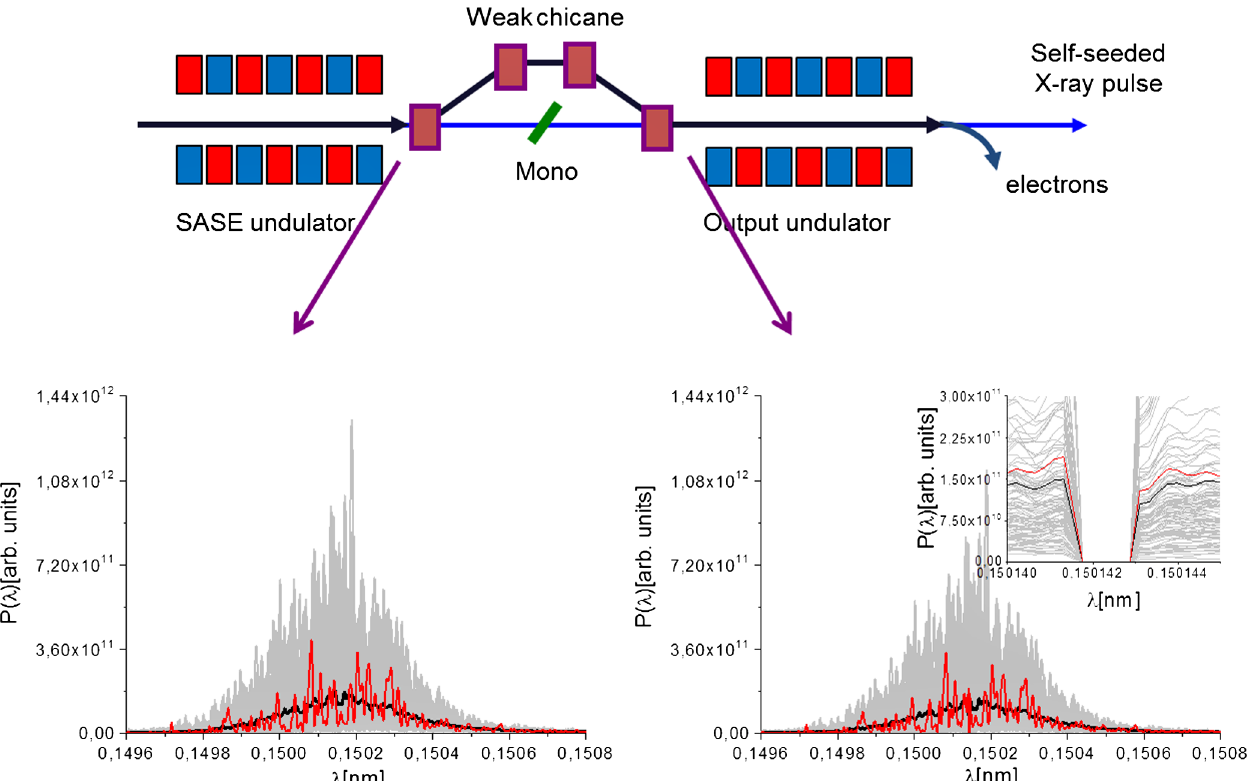
FIG. 1. Schematics of the single-crystal HXRSS principle. The crystal basically acts as a notch filter. The grey lines show one hundred different shots, the black line is the ensemble average, and the red is one particular shot. The effect of the crystal is hard to spot on the scale of the SASE bandwidth: An enlargement of the spectral region of interest (right top inset of the right plot) shows more clearly the notch.